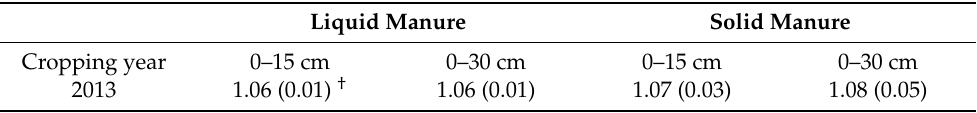
Table 5. Manure P source availability coefficient (PSAC) in the 0–15 and 0–30 cm soil depths after ten years (2004 to 2013) liquid and solid swine manure application based on crop P needs under corn-soybean rotation in a clay loam soil, Ontario, Canada.